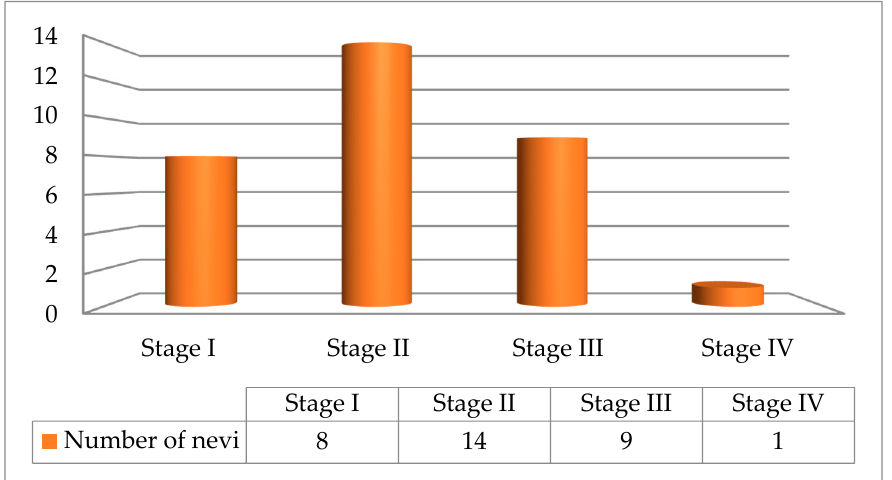
Figure 2. Stages proportion in our investigated group with Sutton nevi.